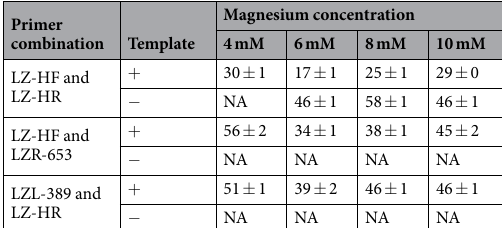
Primer combination Template